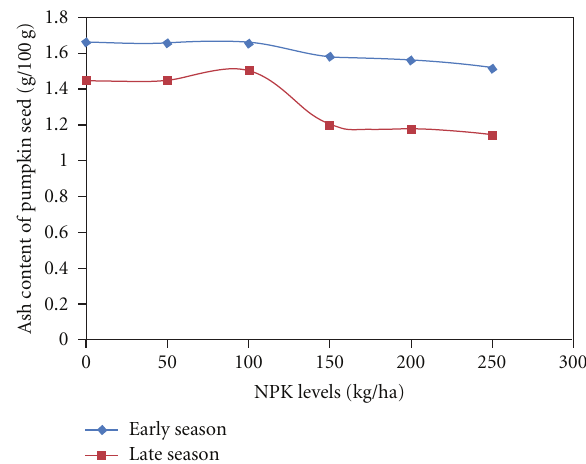
Figure 2: Ash contents of pumpkin seeds as a ff ected by season by NPK